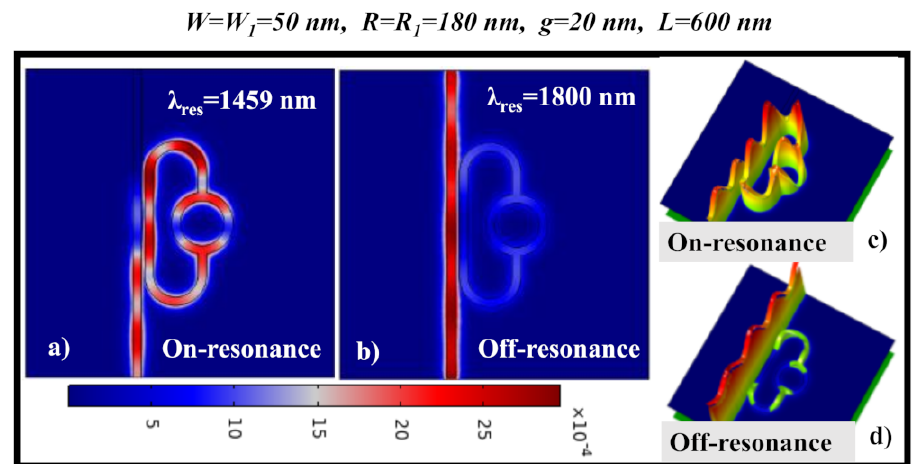
Figure 7. 2D-normalized H-field distribution in the racetrack integrated circular cavity: ( a ) on-resonance, ( b ) off-resonance. 3D-normalized H-field distribution in the racetrack integrated circular cavity: ( c ) on-resonance, ( d )